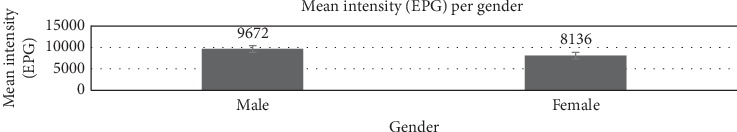
Mean intensity of infection with A. lumbricoides in eggs per gram (epg) in the male and female children. Both of the sexes were randomly enrolled in the study and therefore had almost similar representation in distribution within the five villages sampled.